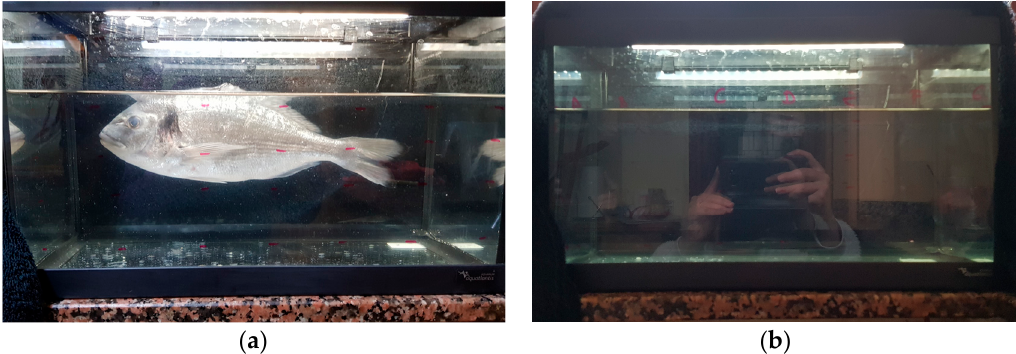
Figure 15. Experiments to demonstrate the operation of fish behavior sensor, preliminary test ( a ) presence and ( b ) absence of the fish. ( a ) presence and ( b ) absence of the fish. Sensors 2018 , 18 , x FOR PEER REVIEW